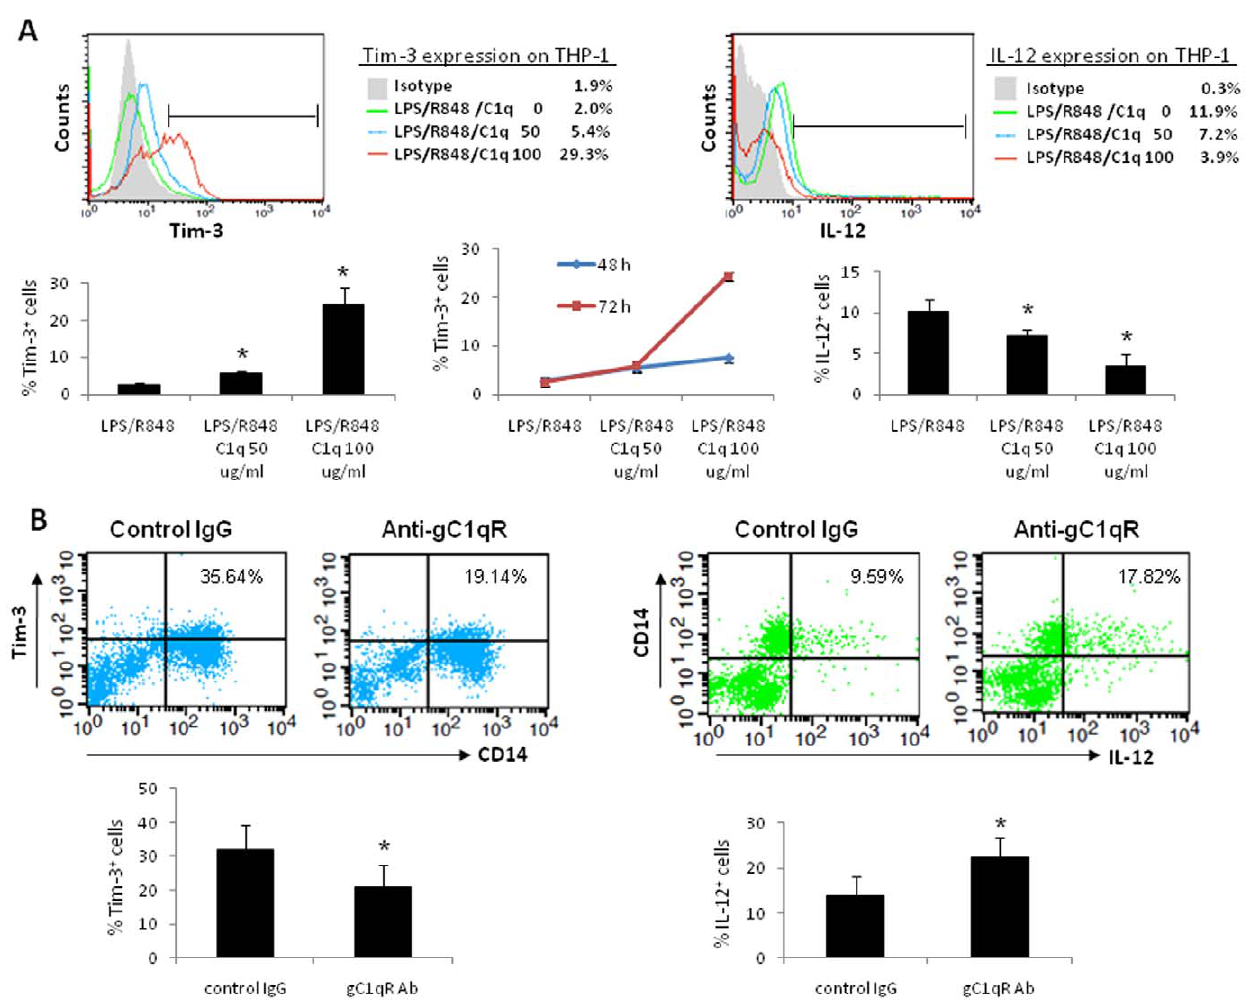
Figure 5. HCV core mimics C1q function in regulation of Tim-3 and IL-12 expression through interaction with gC1qR. A) Tim-3 and IL- 12 expression in THP-1 cells treated with C1q (0, 50, and 100 m g/ml) for 48 , 72 h. Representative histogram over-layed at 72 h is shown above, and summary data from 3 independent experiments is shown below. B) Regulation of Tim-3 and IL-12 expression in M/M Ø by HCV core protein in a gC1qR-dependent manner. PBMC were pre-incubated with anti-gC1qR or control serum overnight, followed by the stimulation with LPS/R848 in the presence of HCV core protein for 18 h. Cell surface Tim-3 and intracellular IL-12 expression was detected by flow cytometry. Data are reproducible in 6 independent experiments.